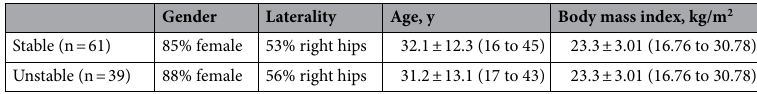
Table 1. Patient demographic data on stability